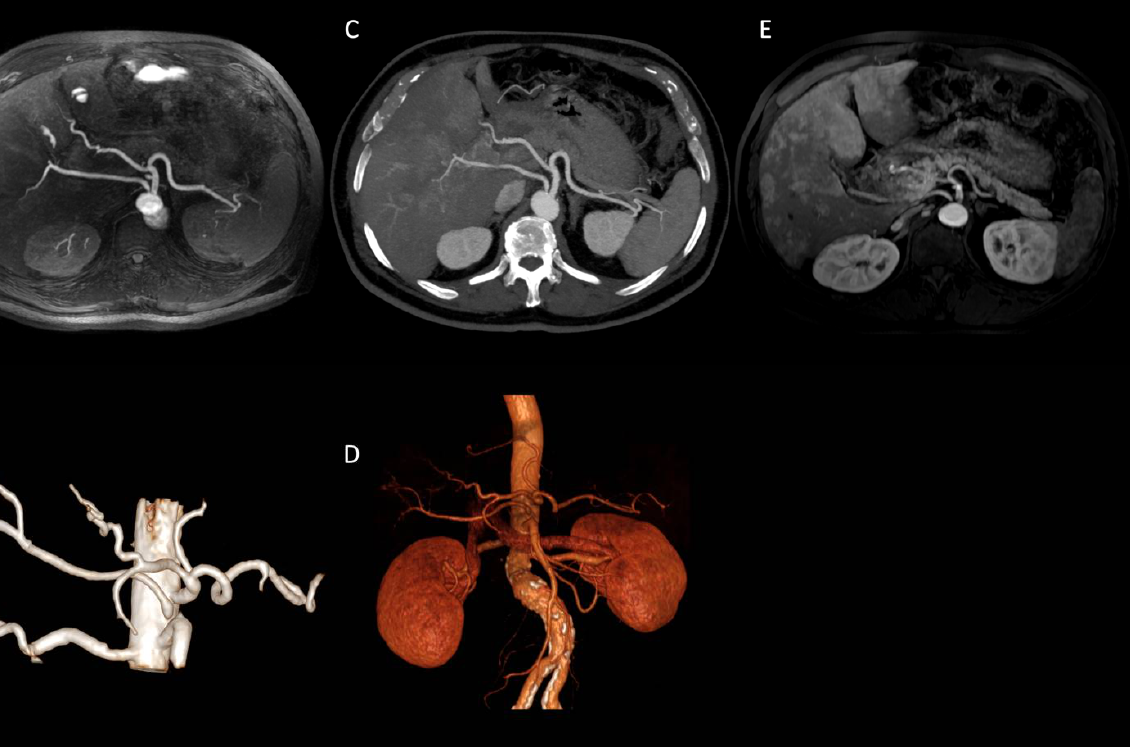
Figure 2. Axial IFIR-MRA ( A ) and CTA ( B ) MIP reconstructions properly showing the direct origin of the right hepatic artery from the aorta (Type XI according to Michels’ classification system) and the remaining main celiac trunk branches up to the proximal bifurcations (spleen and hepatic hilum). On MRA ( C ) MIP reconstruction image quality and resolution are lower, not allowing the proper assessment of proximal bifurcations. IFIR-MRA ( D ) and CTA ( E ) 3D reconstructions, showing a comparable diagnostic performance.